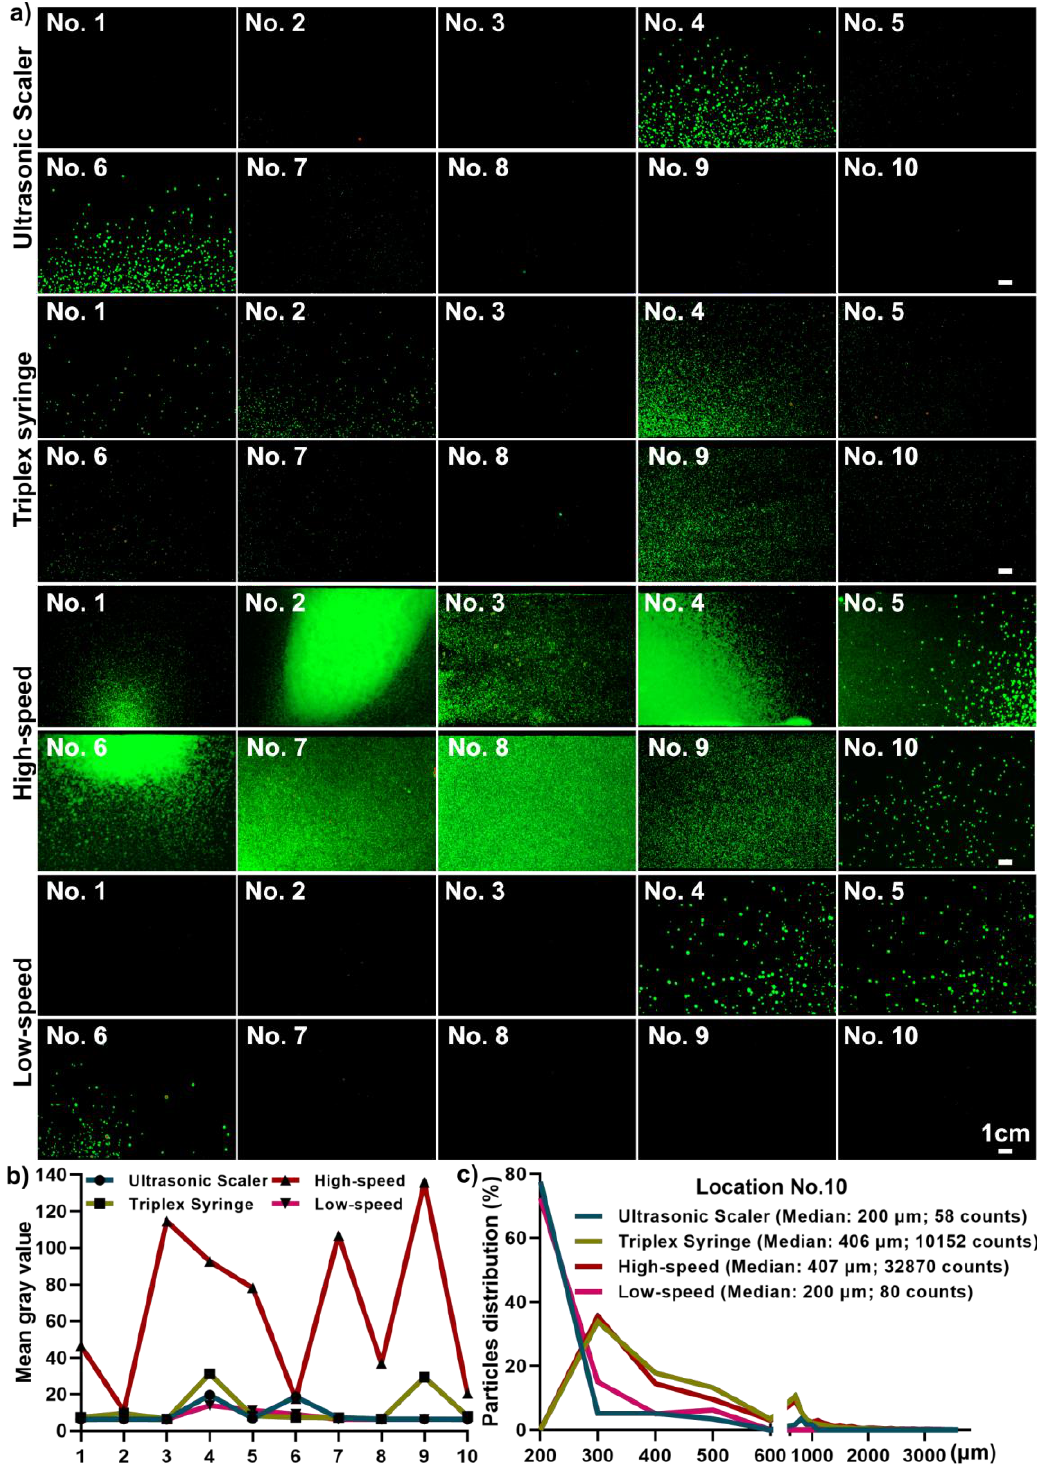
Figure 2. ( a ) Representative splatter images; ( b ) mean fluorescence intensity across 10 locations (after images were converted into grayscale); ( c ) particle distributions at location 10 after 15 s use of the ultrasonic scaler, triplex syringe, high-speed handpiece and low-speed handpiece.